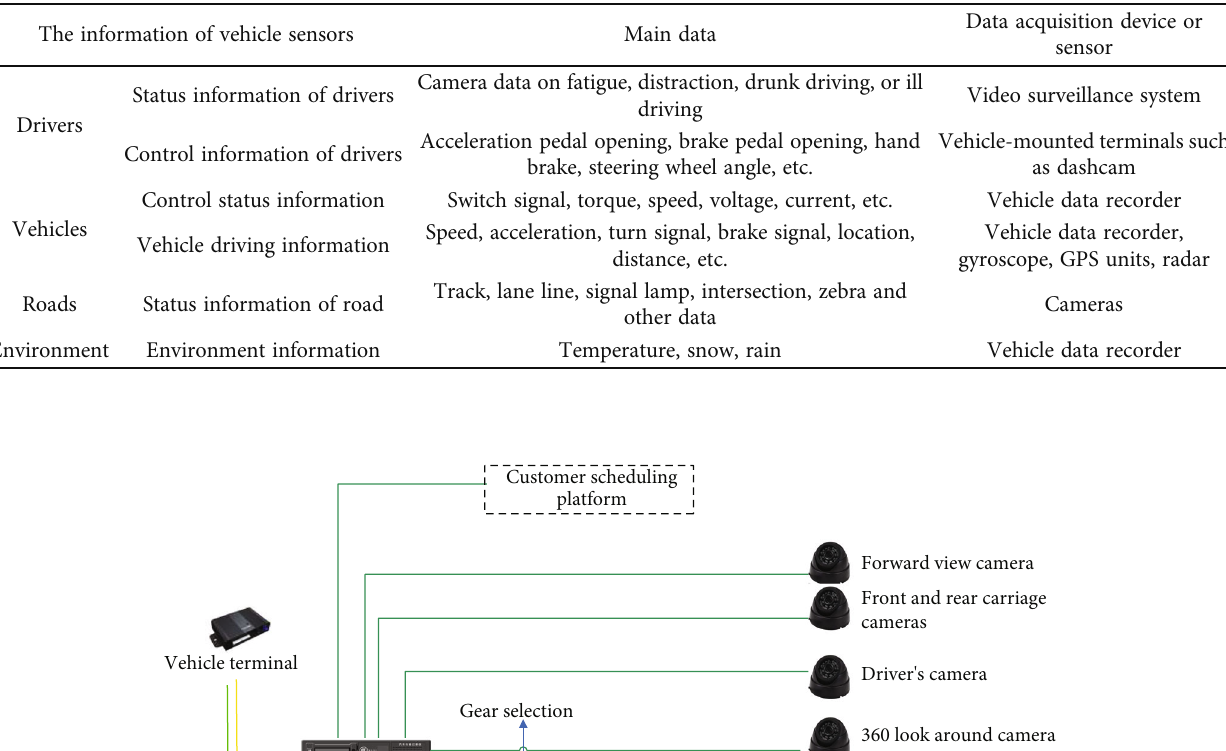
Table 1: The main vehicle sensor information.